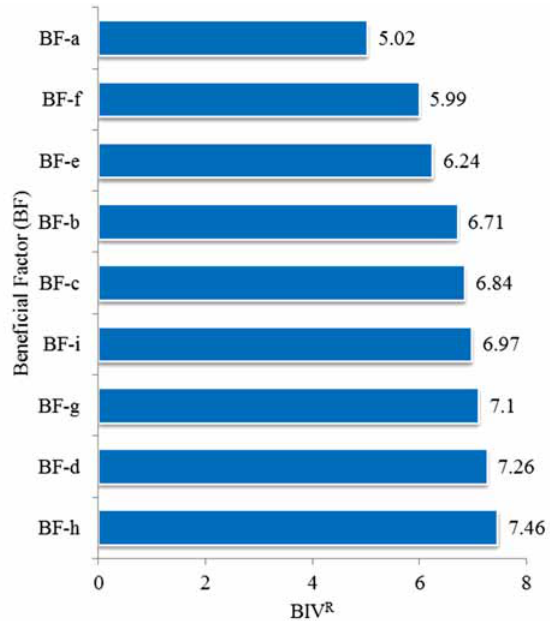
Fig. 1. Ranking profile of the beneficial factors perceived by Nigerian construction professionals